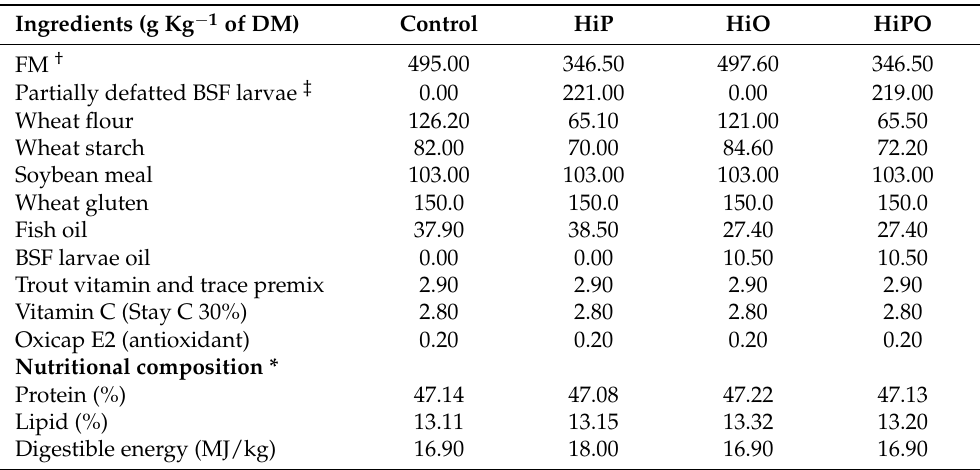
Table 1. Ingredients and nutritional composition of experimental diets fed to juvenile barramundi, Lates calcarifer